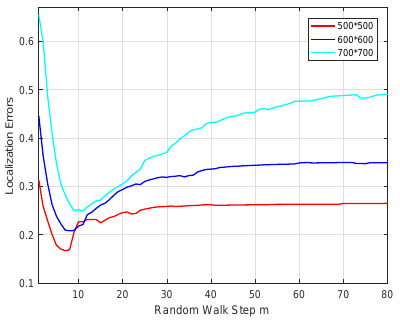
Figure 7. Localization errors with variable m